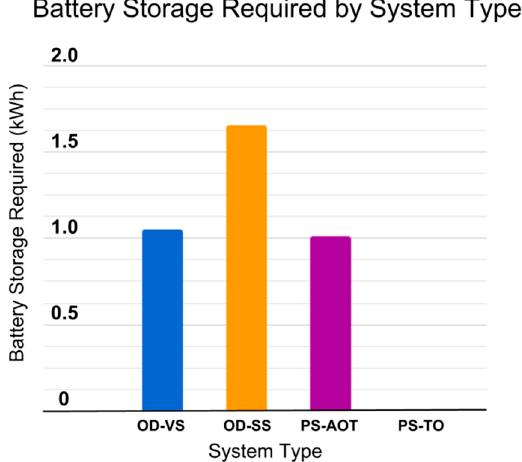
Figure 5. This figure shows the OD-SS model requires the highest amount of battery storage (1.65 kWh), and the PS-TO is the lowest (0 kWh). We see the battery storage requirements for the OD-SS, OD-VS and PS-AOT systems are relatively similar due to the UV Lamp energy being the main driver for this storage energy.